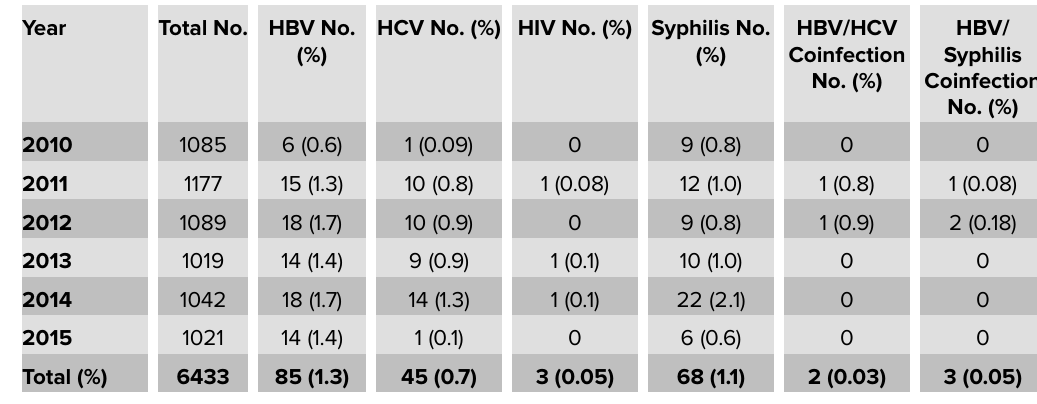
TABLE 2: Distribution of transfusion transmissible infections by years among healthy blood donors in Dongola Specialized Hospital from 2010 to